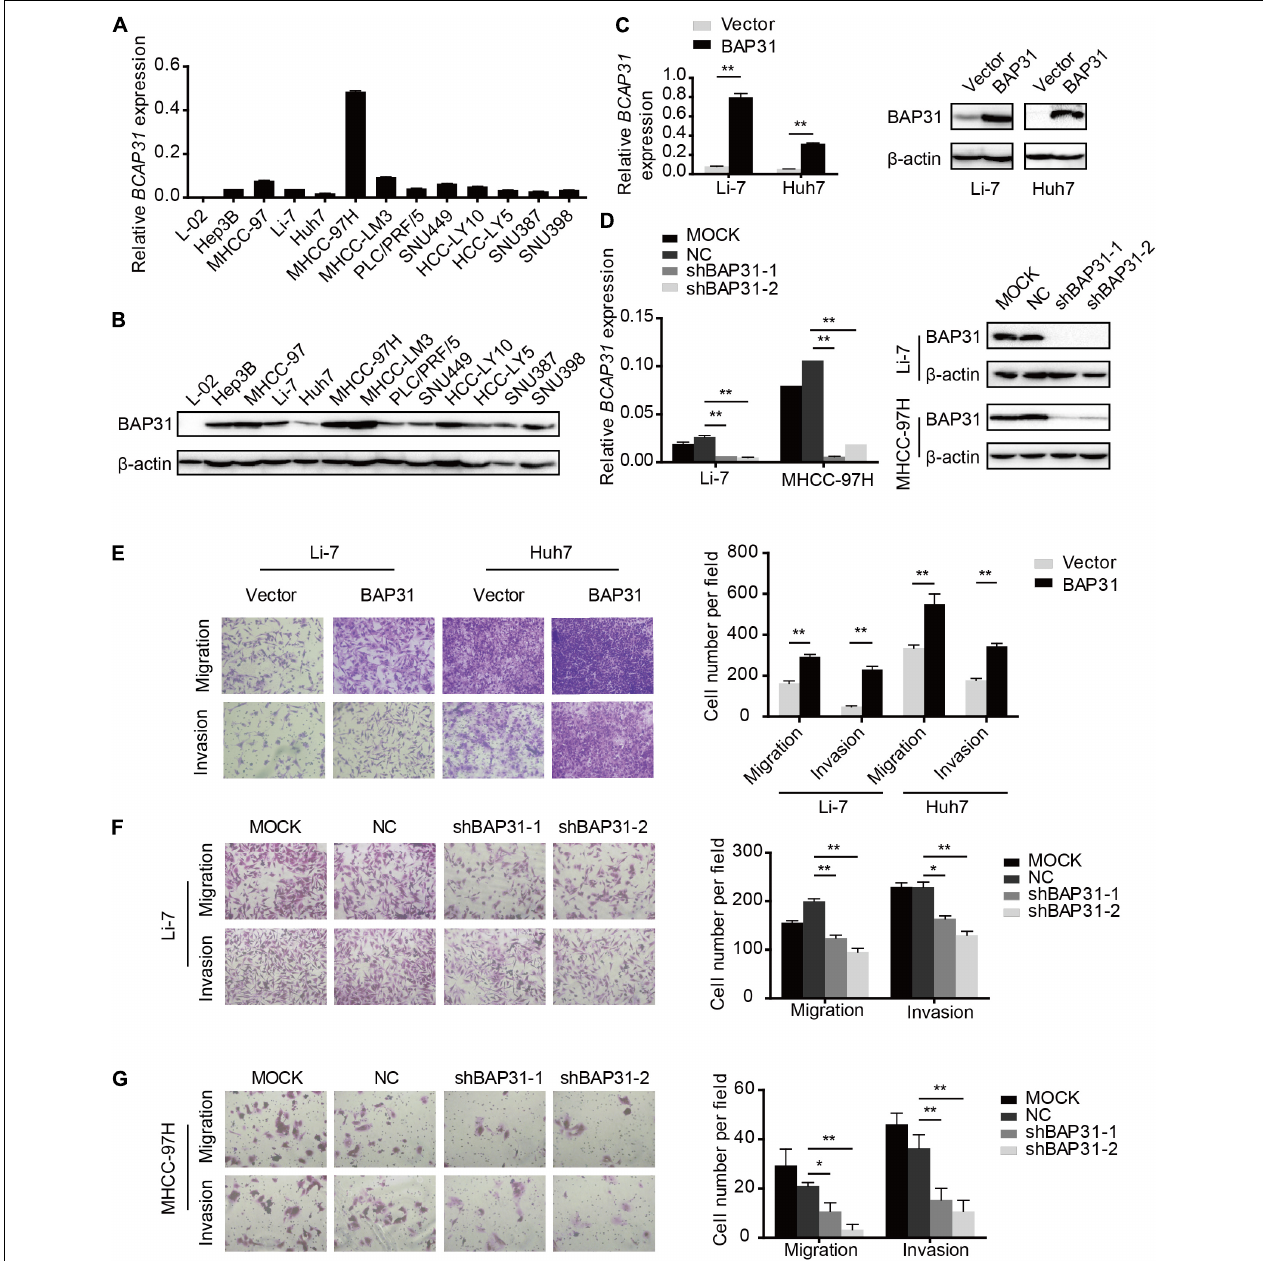
FIGURE 2 | BAP31 facilitated HCC cell migration and invasion in vitro . (A) Relative mRNA expression level of BAP31 in normal liver cell L-02 and HCC cell lines. (B) Relative protein expression level of BAP31 in normal liver cell L-02 and HCC cell lines. (C) Relative mRNA and protein level of BAP31 in BAP31-overexpressed and vector control Li-7 and Huh7 cells. (D) Relative mRNA and protein level of BAP31 in Li-7 and MHCC-97H cell, which were divided into four groups: MOCK, NC, shBAP31-1, shBAP31-2. (E) Transwell assay analysis of the migratory and invasive abilities of HCC cells with BAP31 overexpression. Representative images (left) and the statistical analyses (right) were shown. (F,G) Transwell assay analysis of the migratory and invasive abilities of Li-7 and MHCC-97H cells with BAP31 knockdown. Representative images (left) and the statistical analyses (right) were shown. Results were presented as mean ± SD and t -test was conducted ( n = 3, * p < 0.05, ** p <